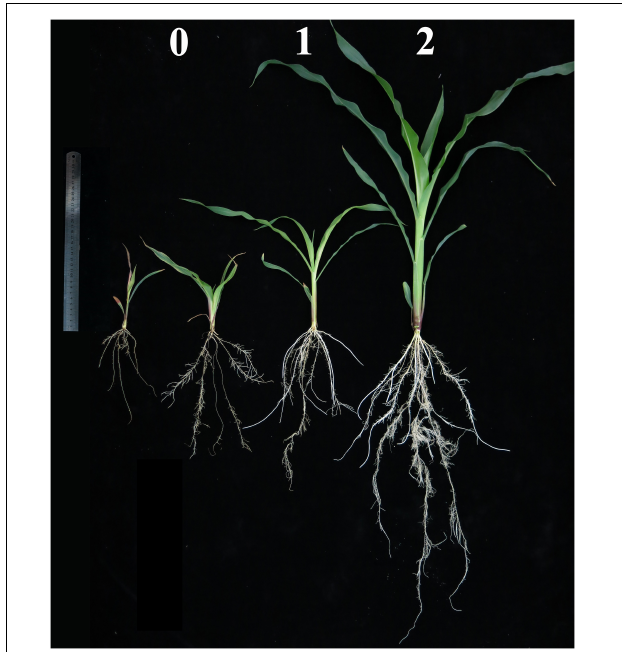
FIGURE 1 | Three scales for Zn score of maize in the RIL population under Zn deficiency. Based on the typical Zn-deficient symptoms in plants on the 15–21th day after transplanting, the Zn score for each plant has been visually recorded three times since the 15th day after transplanting. Three scales (0, 1, 2) are designed to assess the ability of RILs in the Ye478 × Wu312 population to tolerate Zn deficiency under Zn-deficient conditions (0.3 µ mol L − 1 Zn-EDTA). Score-0 plants (two plants on the left) only developed four leaves and showed the severest Zn deficiency symptoms in the shoots, including stunted growth, shortened internodes, small malformed leaves, wrinkled leaf margins and chlorosis and necrotic patches distributed on more than 50% of the areas on all leaves. The root growth of score-0 plants was strongly suppressed, manifested in the great reductions in the root length and number of lateral roots, large-area brown lesions on roots. Compared with the score-0 plants, the score-1 plants showed better growth without brown lesions on roots, but still appeared to have shortened internodes, small malformed leaves and chlorosis distributed on 10–30% of areas on the middle and young leaves. Score 2 represents green healthy plants under Zn-deficient conditions, showing little Zn-deficient symptoms in both shoots and roots when compared with the plants grown in the Zn-sufficient (CK) treatment. The representative shoots and roots are displayed. A ruler of 30 cm length is shown.